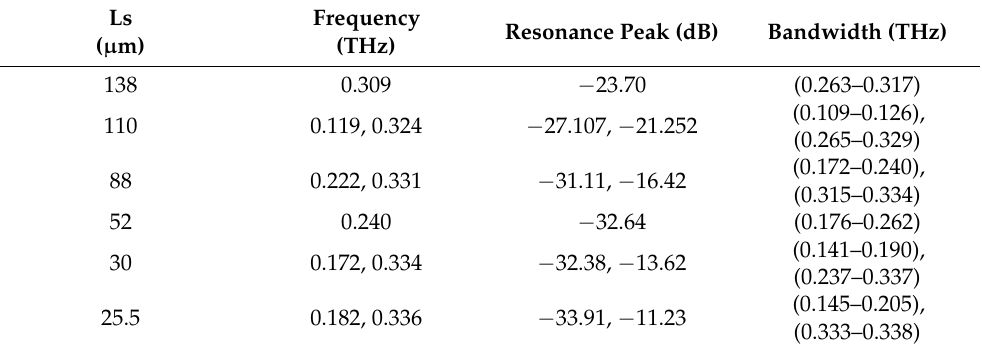
Figure 9. Transmission coefficients tuning when repositioning the ports in the Y -direction. Table 4. Performance comparison of MTM for different slotted-strip line lengths in the Y -direc- tion.